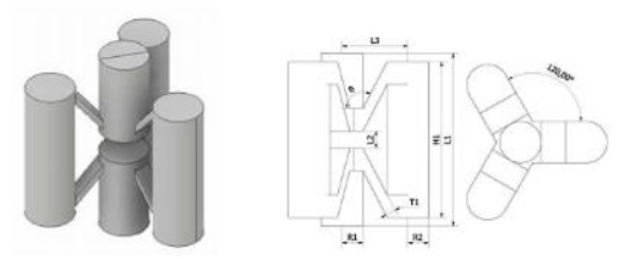
Figure 1: Unit cell purposed for the study and its